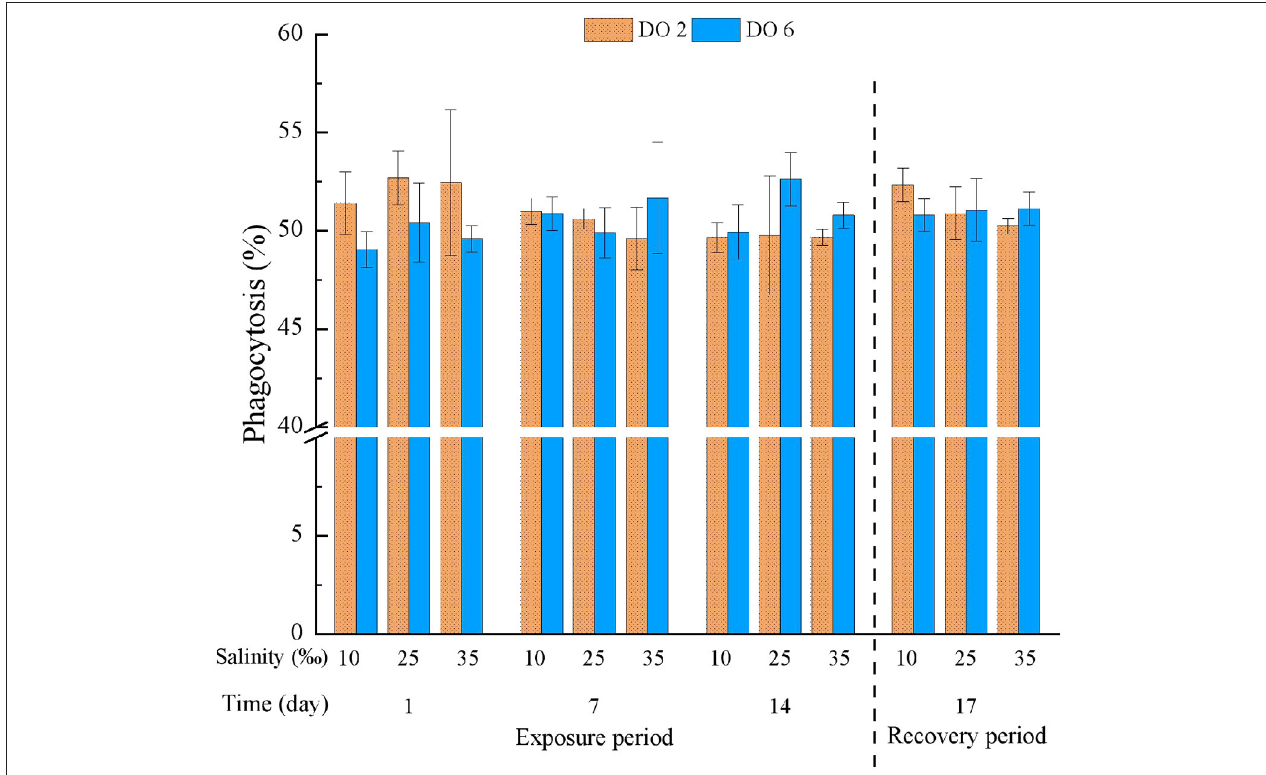
FIGURE 4 | Phagocytosis (PHA) of C. hongkongensis exposed to six combinations of salinity (10, 25, and 35 ‰ ) and DO (2 and 6 mg/L) at 1, 7, and 14 days during the exposure period and 3 days for the recovery period. Different capital letters indicate significant differences among time points within each salinity level in hypoxia level (2 mg/L) or control group (6 mg/L) ( p < 0.05). Different small letters indicate significant differences between salinity within each time point in salinity level in hypoxia level (2 mg/L) or control group (6 mg/L) ( p <